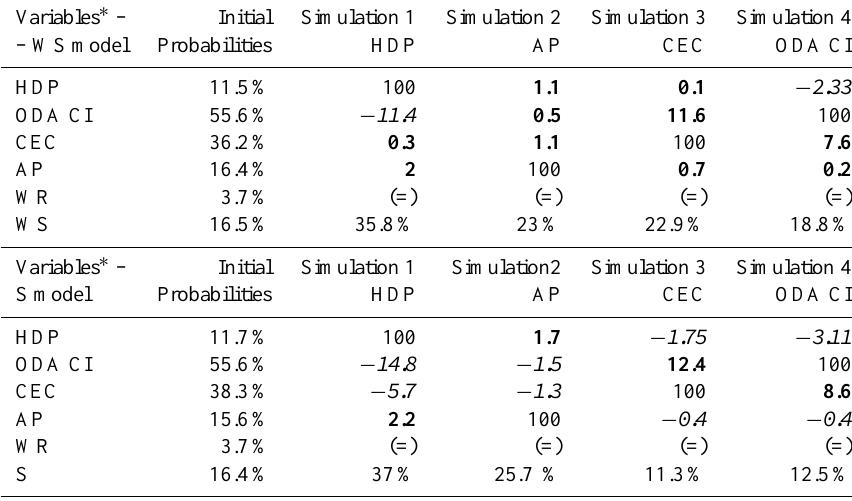
Table 8. Profile 4: water supply and sanitation